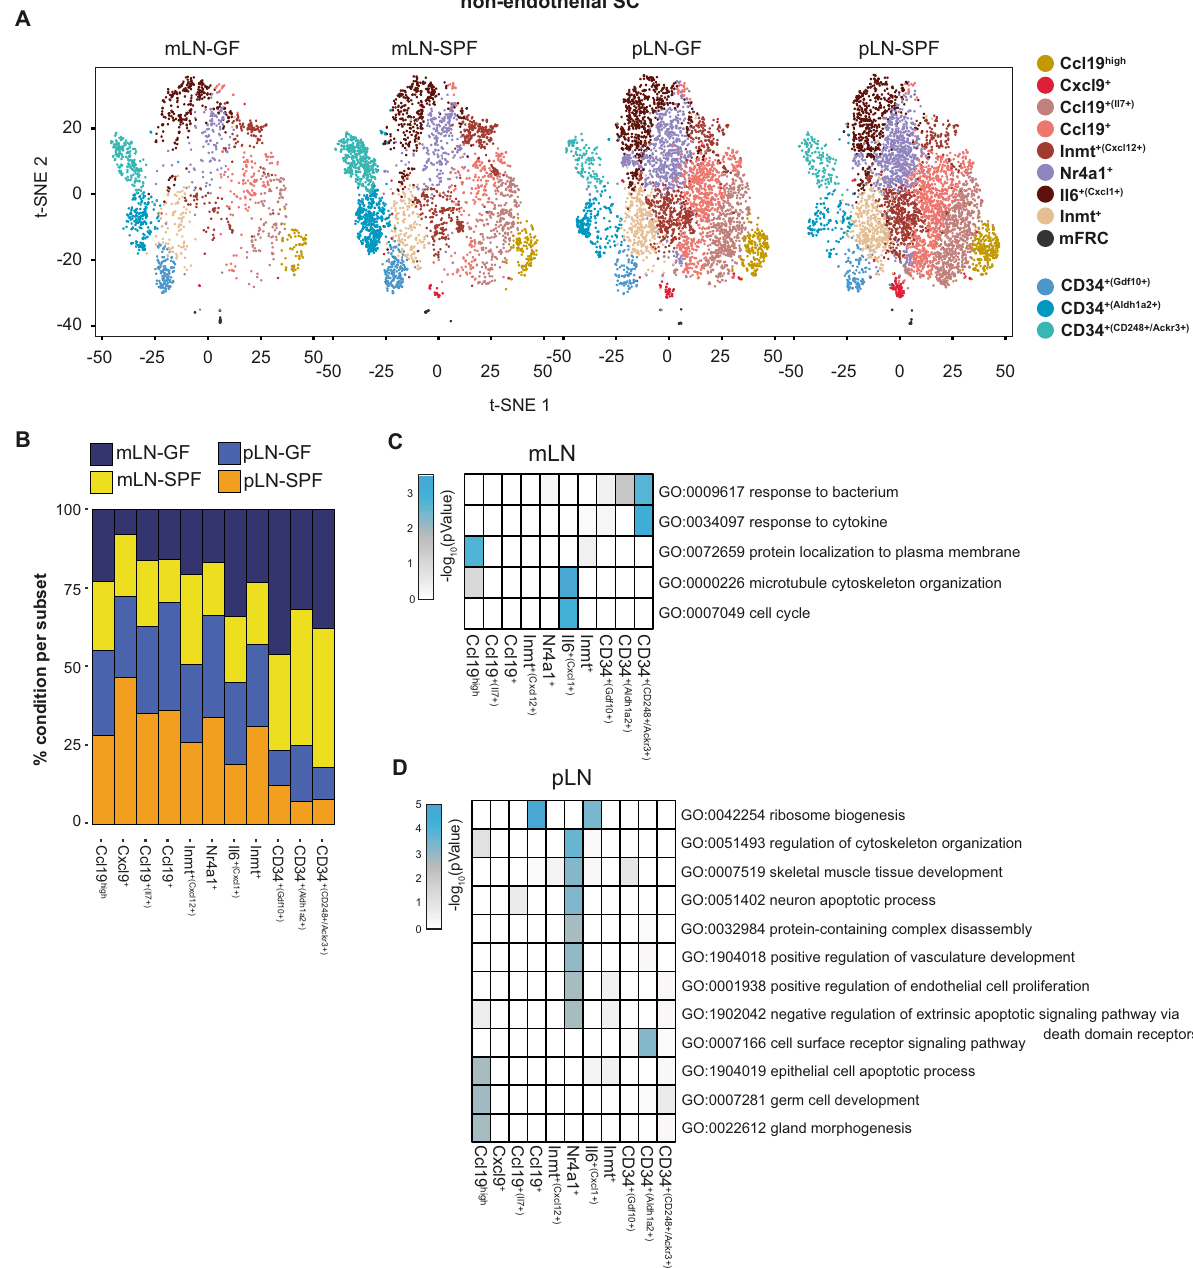
Fig. 3 | Non-endothelial SC subset composition is largely unaffected by microbial colonization. CD45 - CD24 - cells were isolated from mLNs and pLNs of 6 – 10weeksoldGFor7 – 12weeksoldSPF-housedmiceandsubjectedtoscRNA-seq. The scRNA-seq dataset for SPF mice (two replicates per condition) was previously published 11 . One replicate for pLN and mLN from GF mice was newly processed. Non-endothelialSCswereidenti fi ed asnon-LECs,non-BECs,and non-PvCs. A t-SNE plot depicting cluster segregation of non-endothelial SC subsets between GF and SPFmiceformLN(left)andpLN(right). B Bargraphshowingtheproportionofcells within each subset normalized to total cell number belonging to either mLN-GF,